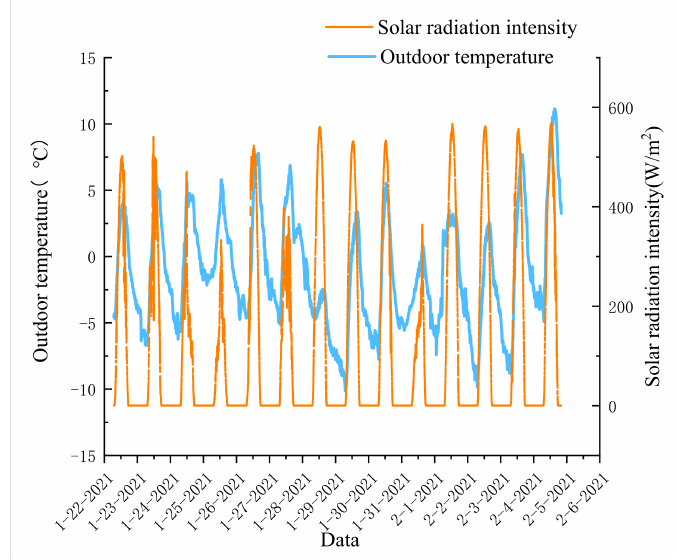
Figure 9. The weather changes during the time of the experiment.